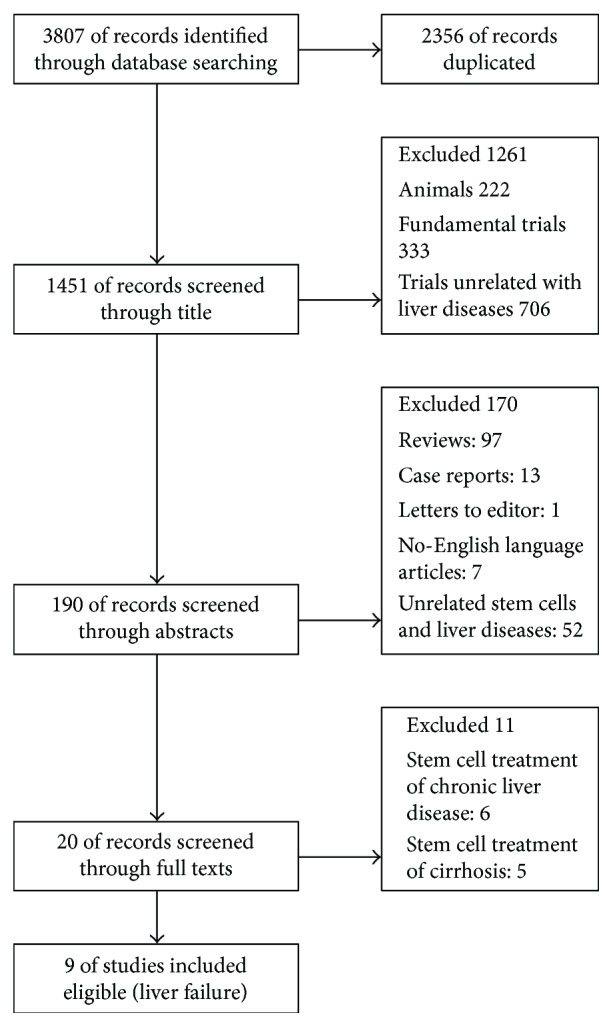
Flow diagram of included and excluded studies in this review.